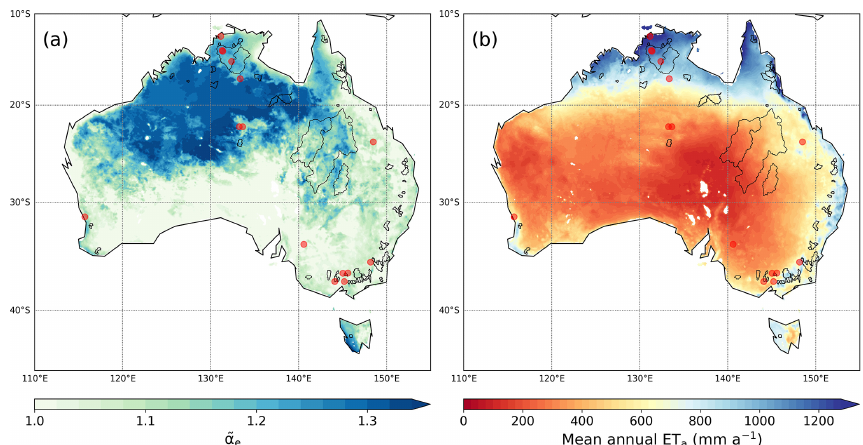
Figure 5. Distributions of (a) the ˜ α e values from Eq. (17) and (b) the mean annual ET a for 1998–2014 by the CR method with the ˜ α e